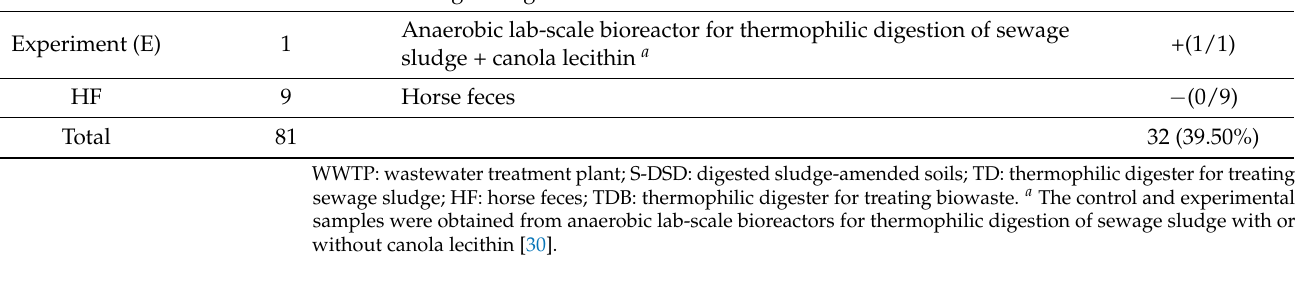
Table 2. Antimicrobial resistance and toxin gene profiles of environmental C. difficile isolates recovered from fecally contaminated environmental